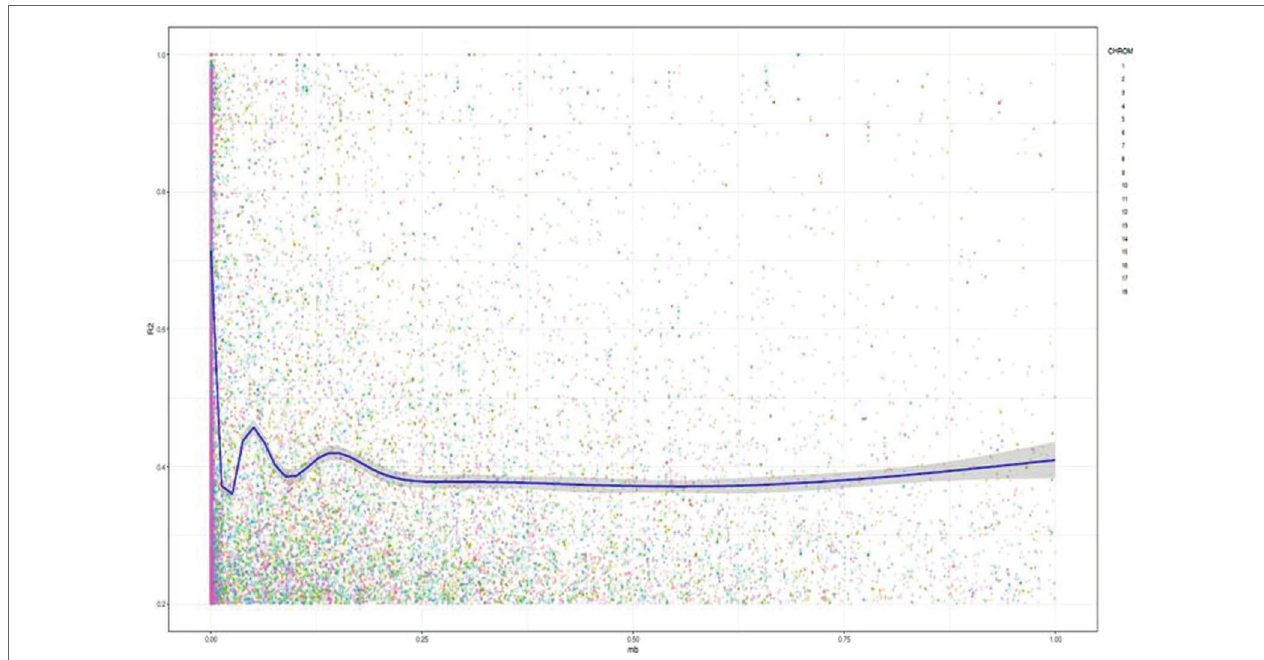
FIGURE 3 | Genome-wide linkage disequilibrium (LD) decay among the SNP pairs as a function of genetic distance in base pairs based on the joint analysis of the 18 chromosomes in 142 cassava accessions. The dots correspond to the observed LD ( r 2 ) values. The blue line represents the nonlinear trend of expected LD decay.